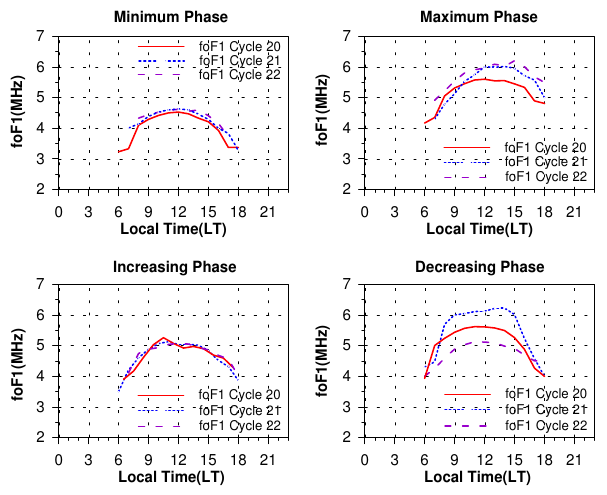
Fig. 9. Similar to Fig. 8 for fo F1.